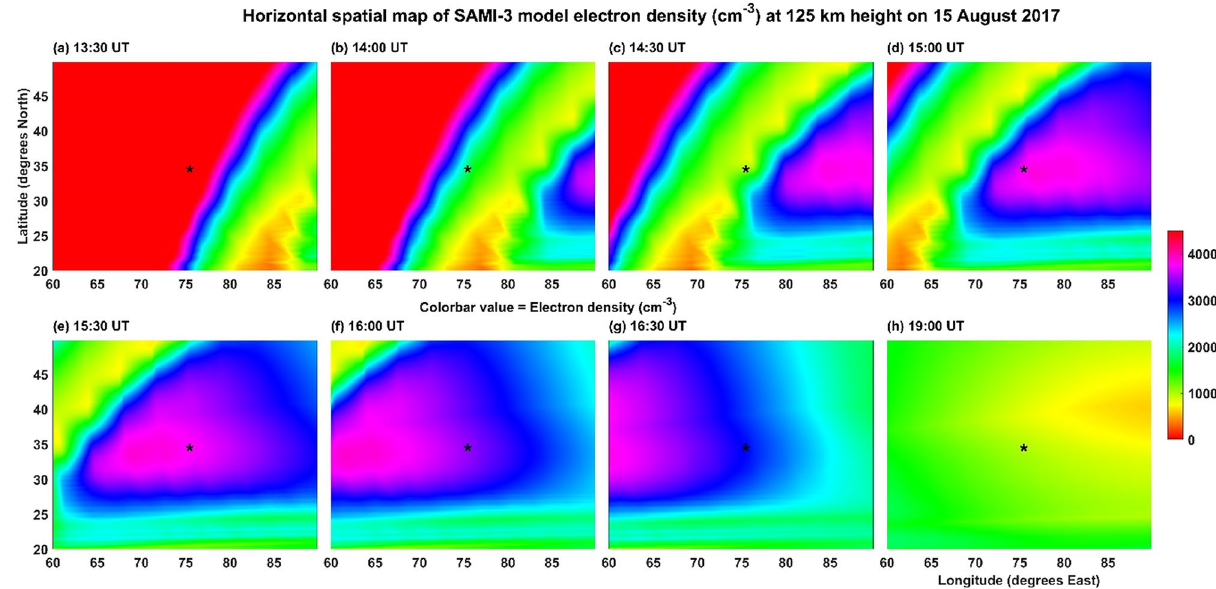
Figure 11. Ilustrates the contour plots (x and y axes for longitude and latitude respectively) of electron density (SAMI3 model) at the height of 125 km centred over the CCD imager location of Srinagar, at ( a ) 13:30 UT ( b ) 14:00 UT ( c ) 14:30 UT ( d ) 15:00 UT ( e ) 15:30 UT ( f ) 16:00 UT ( g ) 16:30 UT and ( h ) 19:00 UT. 0.15° is the resolution in latitudes and longitudes. The CCD imager location in Srinagar is marked as star symbol at the geographical longitude of 75°E and latitude of